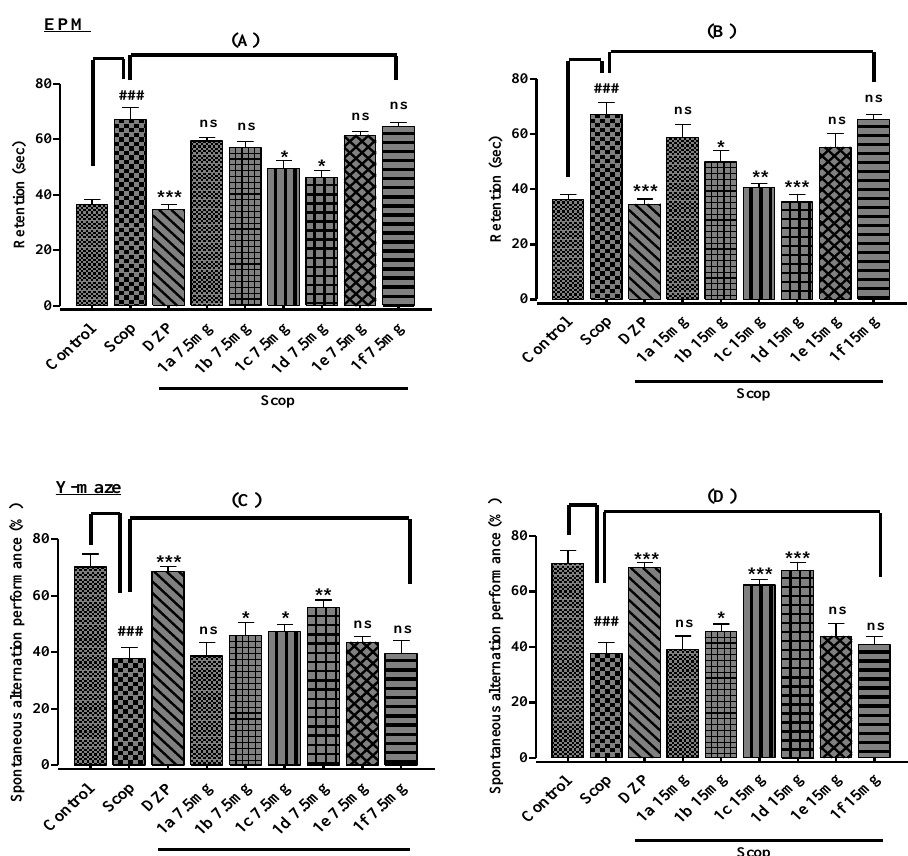
respectively. The curcumin analogs 1d and 1c have showed their effectiveness against memory impairment in amnesic mice.